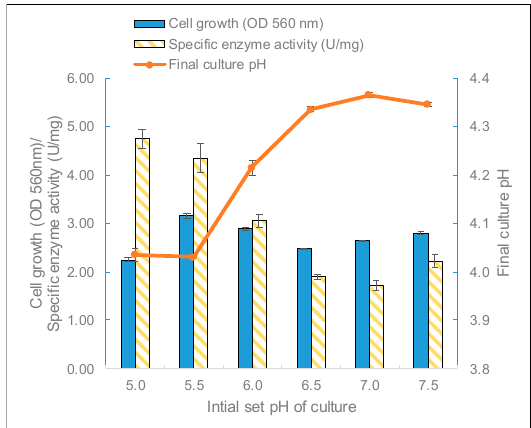
Figure 5. The e ff ect of the initial pH on the biomass, enzyme activity, and pH. The bacteria were grown statically (0 rpm) at 37 ◦ C in 20 mL of MRS broth placed in 30 mL capacity universal media glass bottles. Results are shown as the mean standard deviation of three independent ±